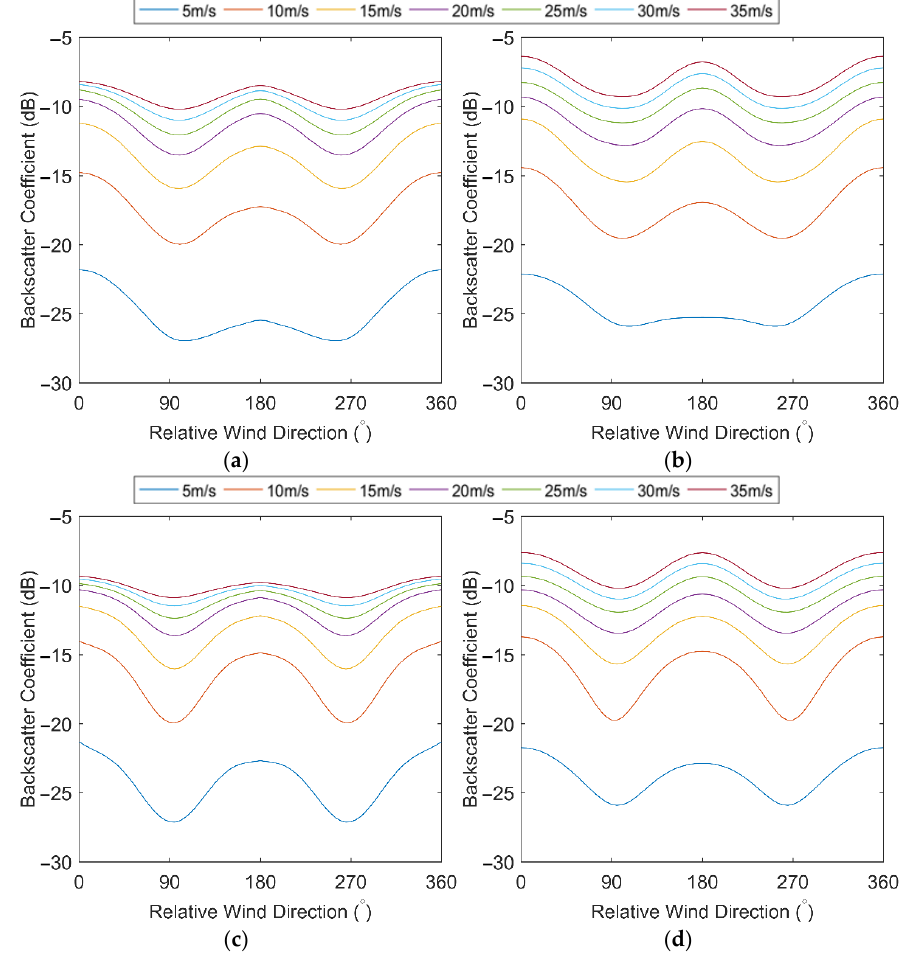
Figure 4. Backscatter coefficient curves of HW ‐ GMF and NSCAT ‐ 2 GMF. ( a ) Curves of HW ‐ GMF for HH polarization. ( b ) Curves of NSCAT ‐ 2 GMF for HH polarization. ( c ) Curves of HW ‐ GMF for VV polarization. ( d ) Curves of NSCAT ‐ 2 GMF for VV polarization.